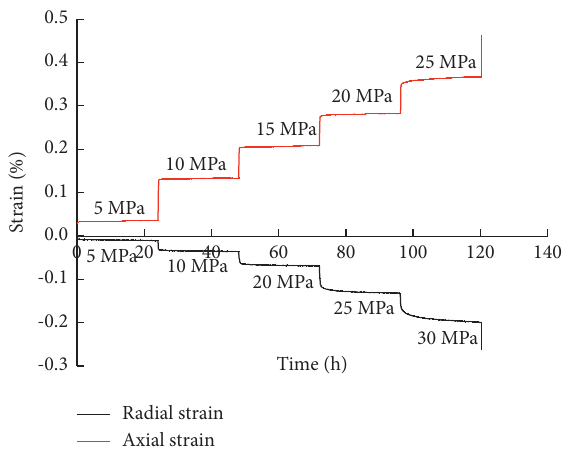
Figure 6: Creep test curve of gneiss.